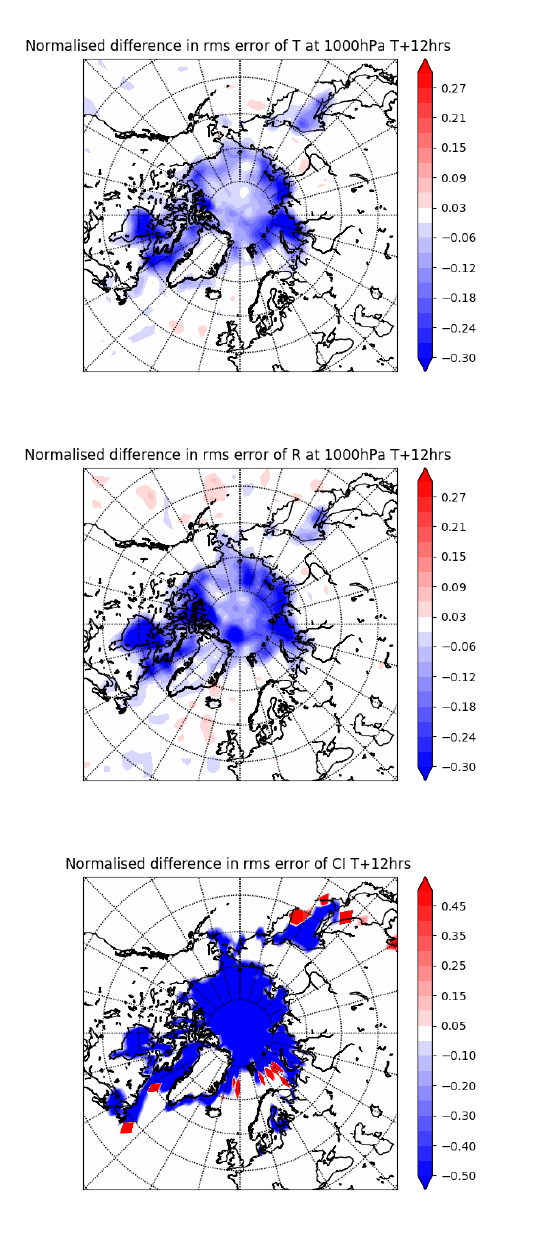
Figure 9. Similar to Figure 8 but focused on the